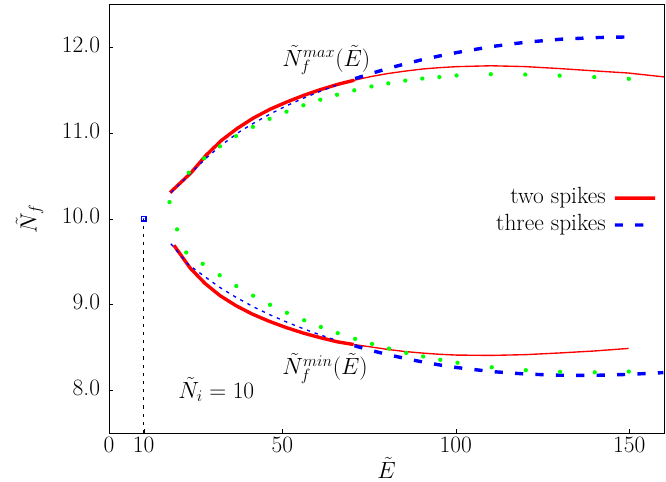
Figure 12 . The initial wave packets (left panels) and evolution of the instantaneous particle number (right panels) for boundary solutions with ~ N i = 0 : 1 and ~ E (cid:25) 0 : 6. Upper and lower panels correspond to upper and lower boundary solutions respectively.